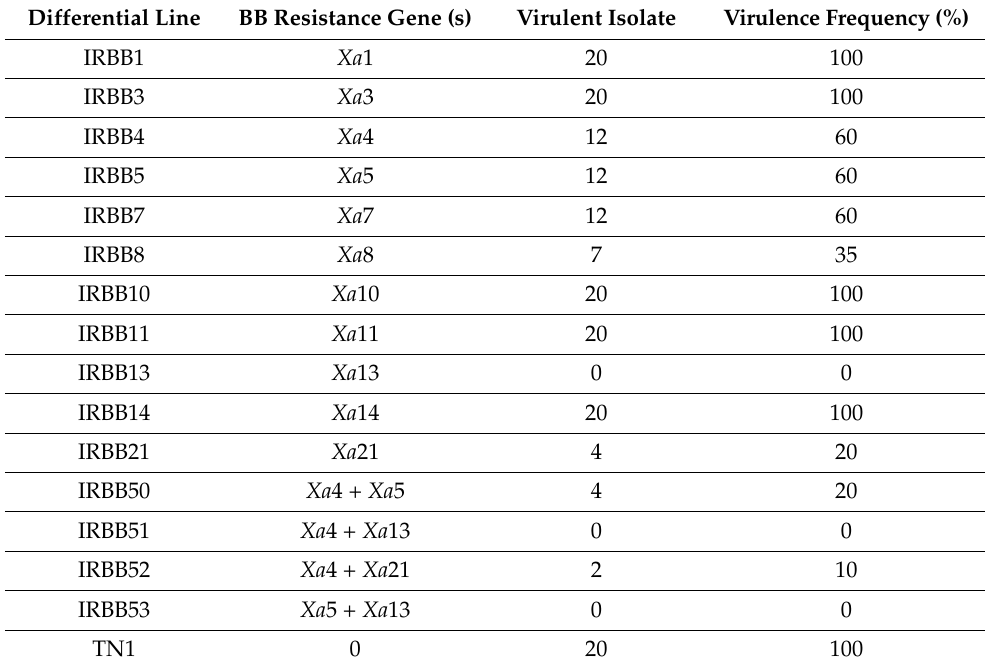
Table 8. Virulence frequency of Xanthomonas oryzae pv. oryzae isolates against Xa genes. Differential Line BB Resistance Gene